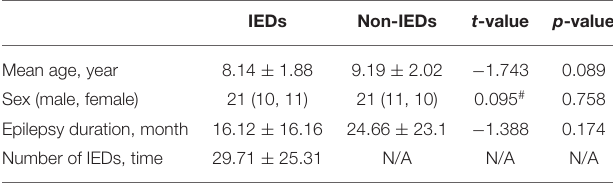
TABLE 1 | Characteristics of